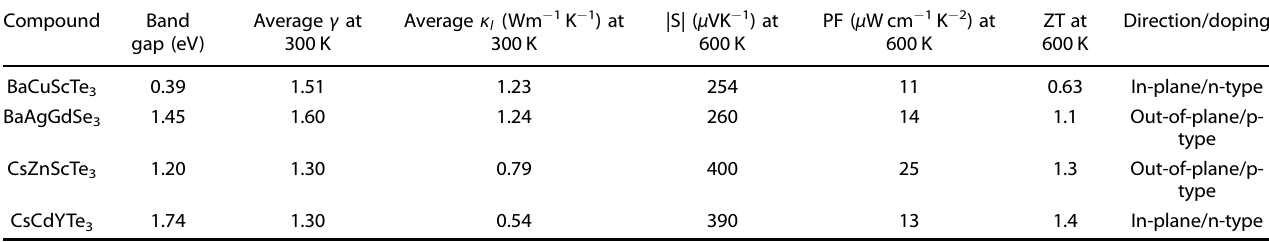
Table 2. Suggested compounds for experimental synthesis and characterization.